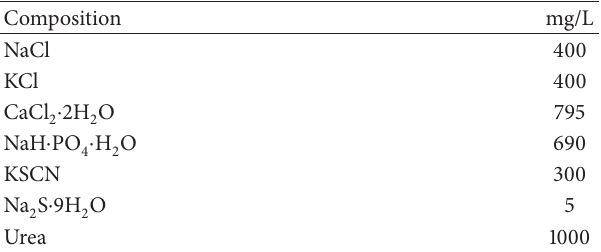
Table 1: Modified Fusayama artificial saliva used in this